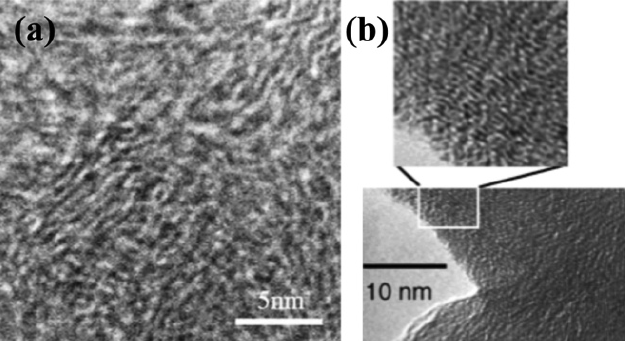
Figure 5. TEM micrographs of ( a ) bidirectionally grown double helical carbon filament [24] and ( b ) a single helical carbon tubule nanocoils [6]. Reprinted with permission from [6], Copyright 2000 Japan Society of Applied Physics; Reprinted with permission from [24], Copyright 2004